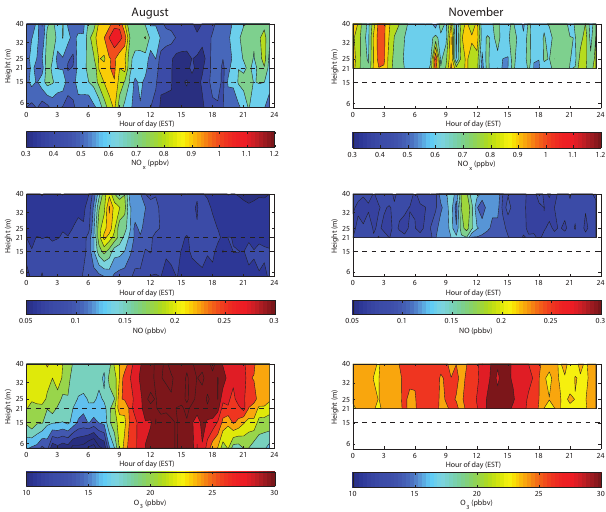
Fig. 4. Mean diurnal cycles of NO x , MO , NO, and O 3 mixing ratio profiles from the UMBS AmeriFlux site for August and November 2008. The area between the dashed lines in the plots denotes the crown layer. Gaps in the data below the crown layer in November are due to failures in the 4 and 15m switching